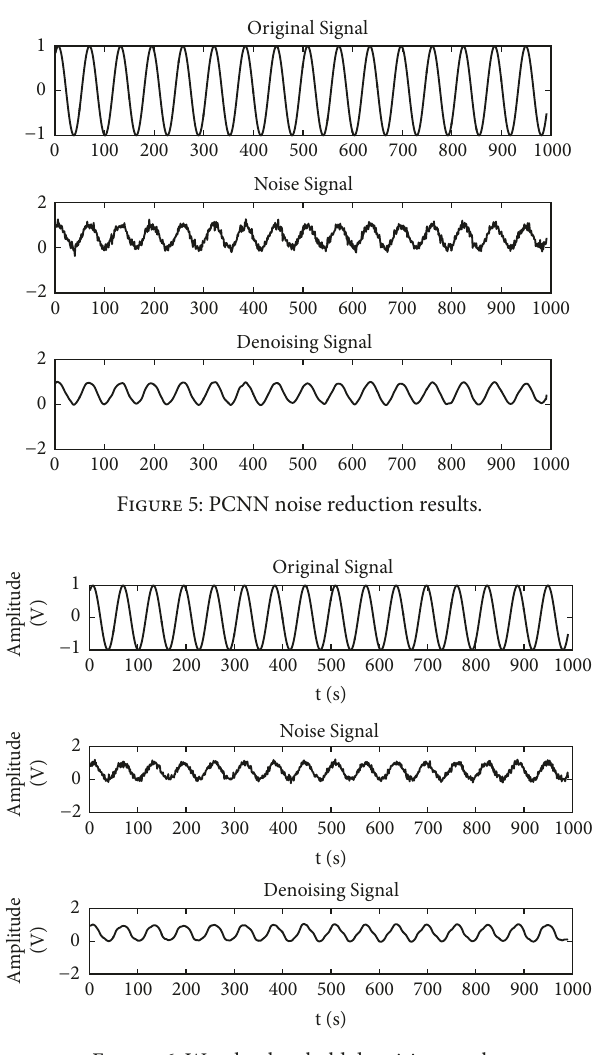
Figure 6: Wavelet threshold denoising results. Table 1: Comparison of wavelet threshold denoising and PCNN noise